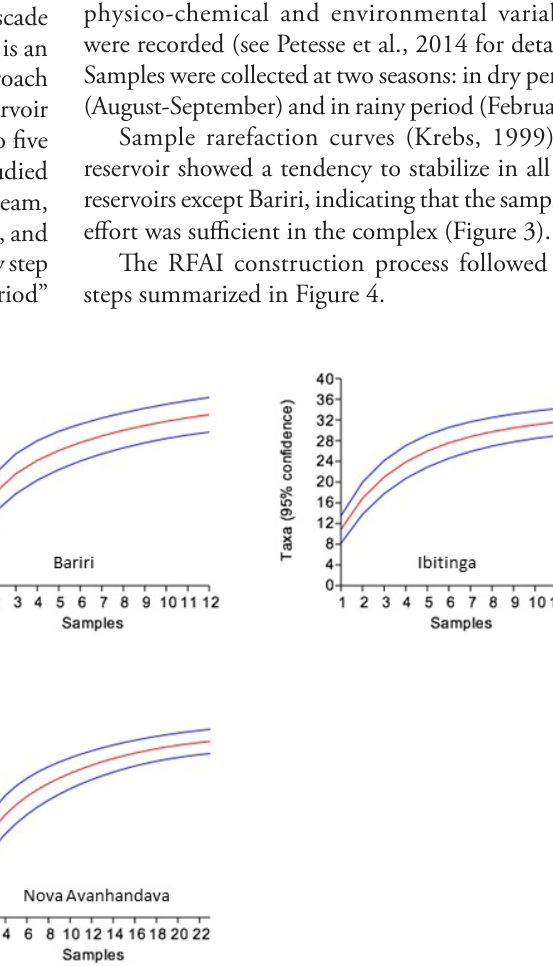
Figure 3. Rarefaction curves by samples based on the non-parametric Chao2 estimator (Colwell et al., 2004) applied to species presence/absence data of the Tietê cascade reservoir system (SP, Brazil). Blue lines = 95% confidence